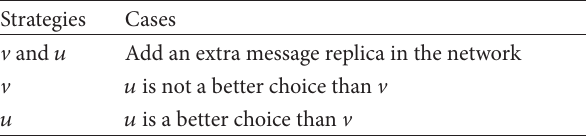
Table 2: Optional opportunistic routing decisions.